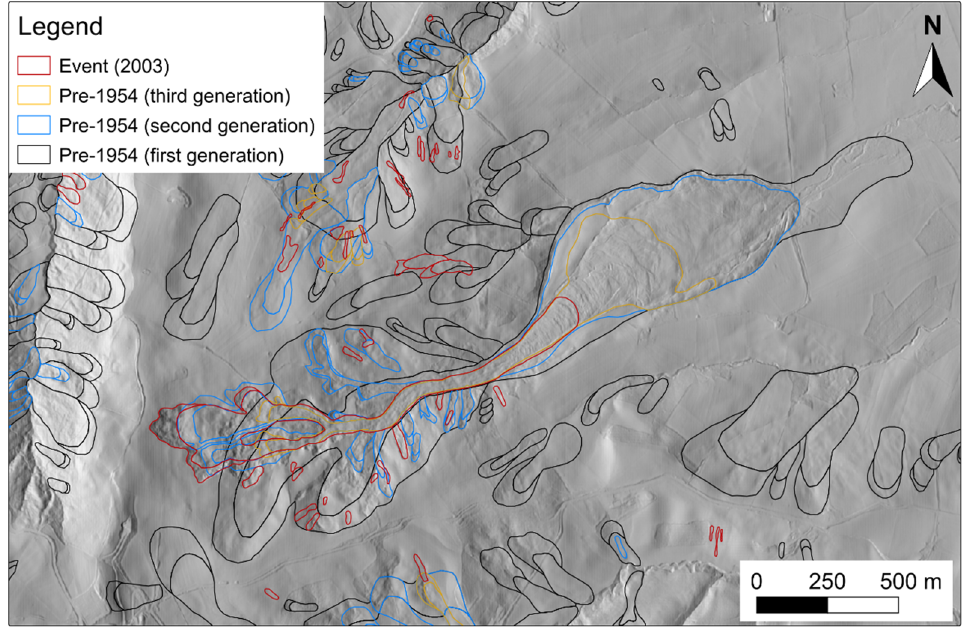
Figure 2. Excerpt of the geomorphological landslide inventory map of the Alberona test site . Base map: shaded relief obtained from the LiDAR data provided by Regione